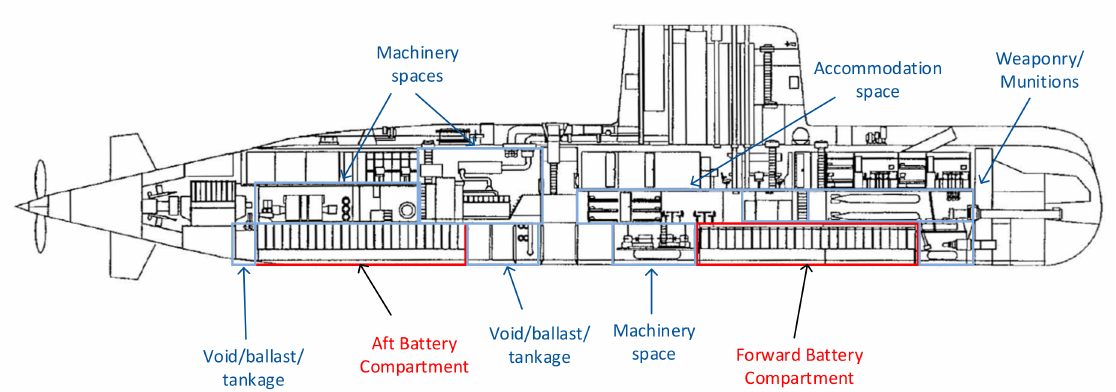
Figure 4. Battery Compartment Location